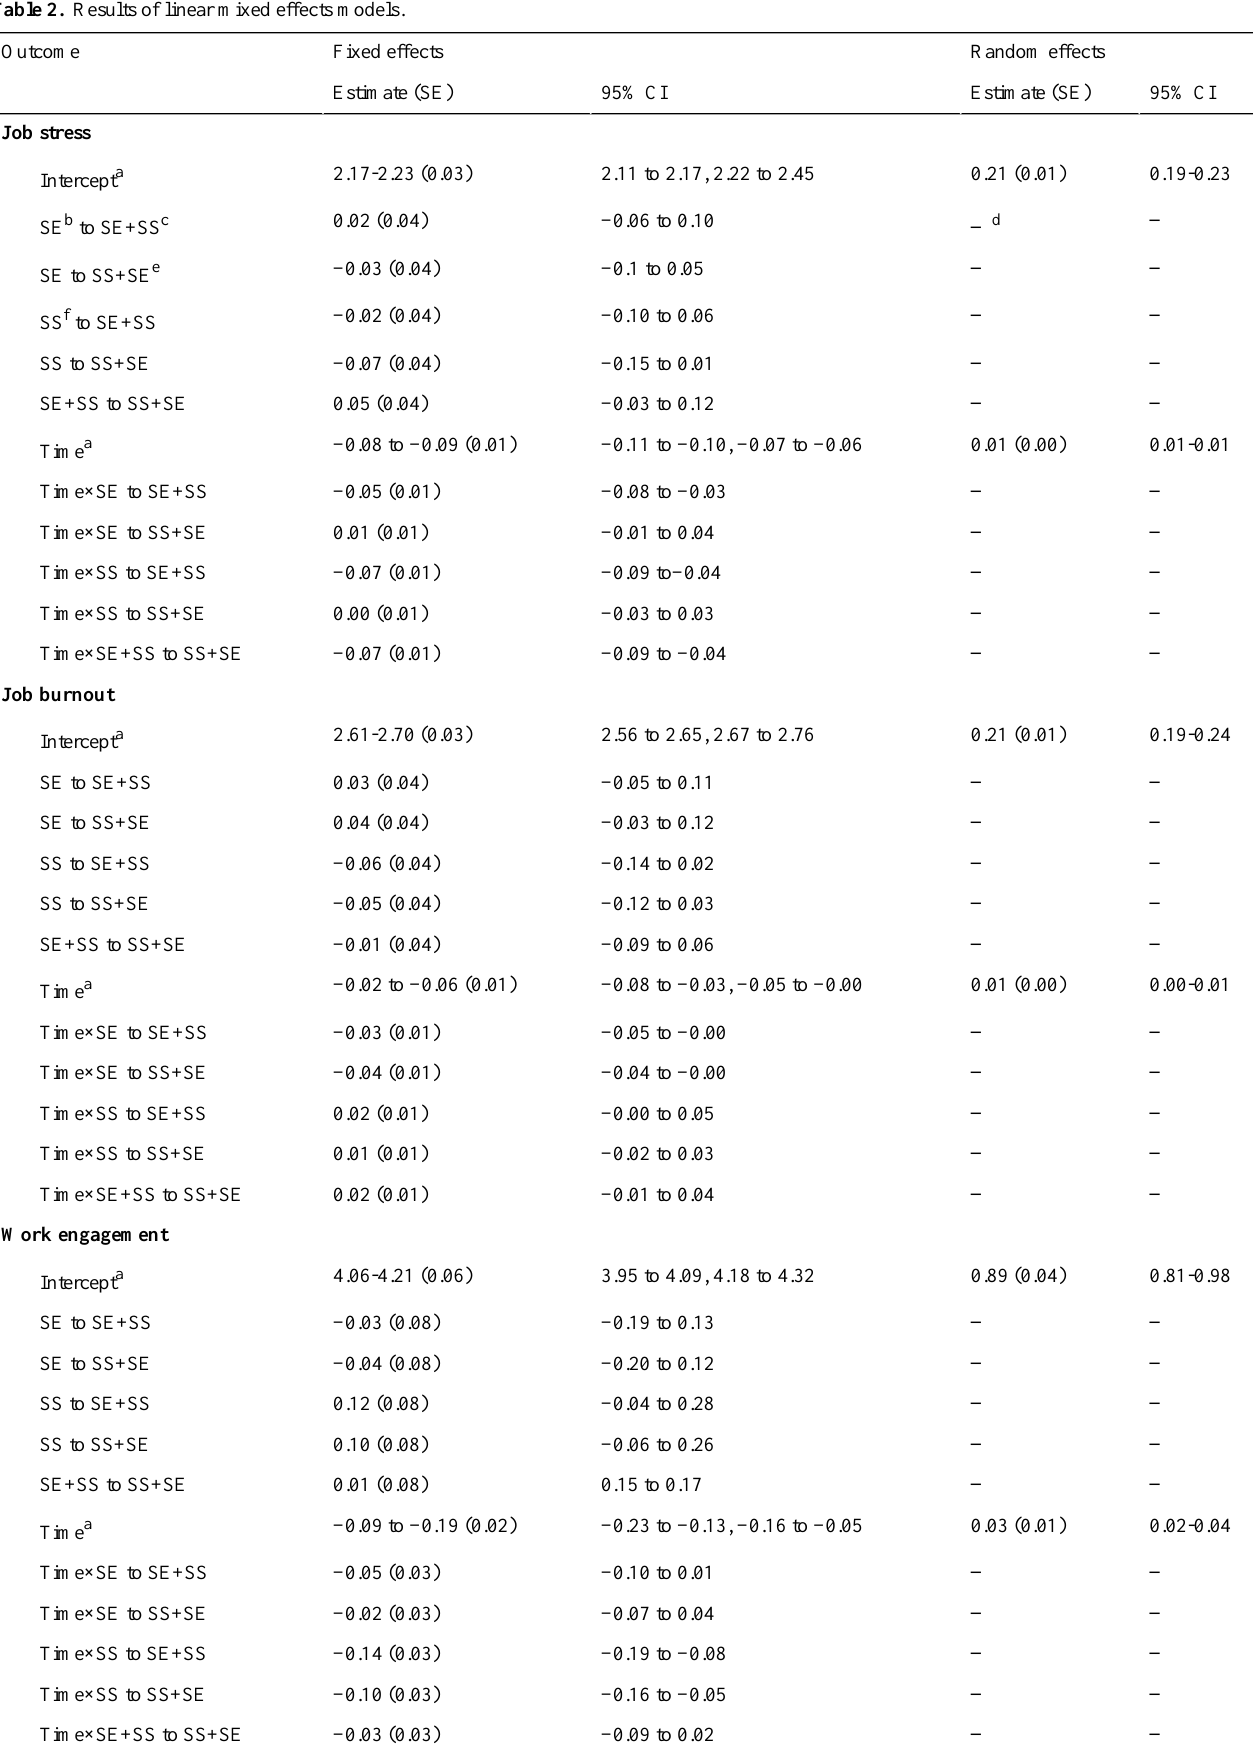
Table 2. Results of linear mixed effects